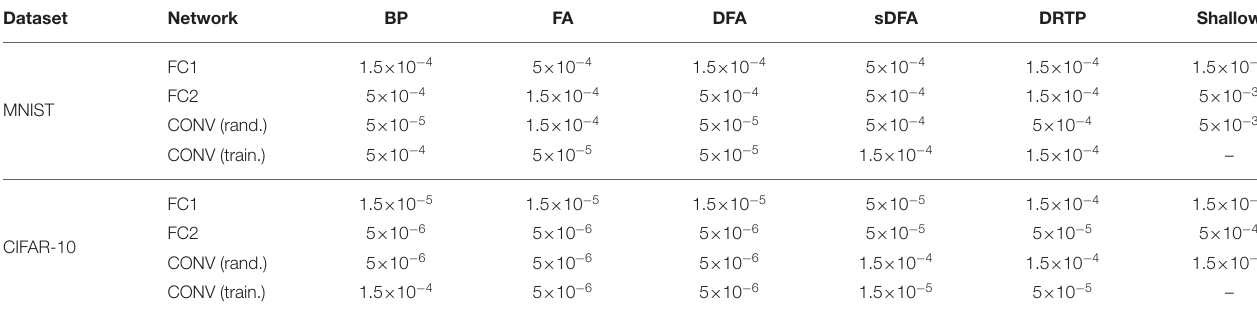
TABLE 3 | The learning rate values for the MNIST and CIFAR-10 datasets are selected based on a grid search. Dataset Network BP FA DFA sDFA DRTP Shallow